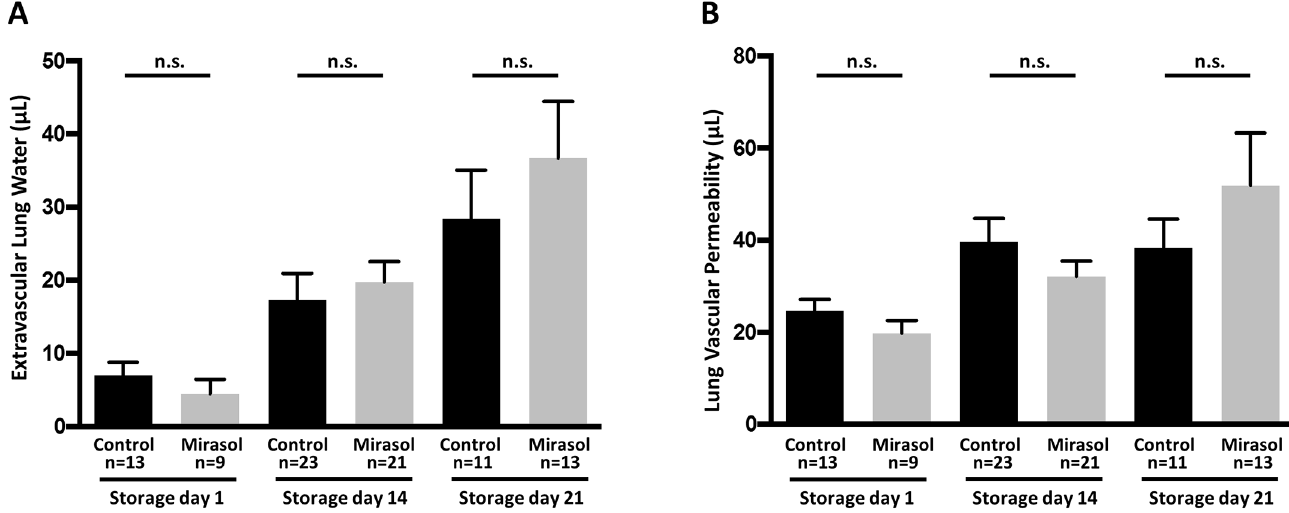
Fig 3. Lung injury measurements in control or Mirasol treated blood transfused into BALB/c SCID mice. LPS priming plus a 25% exchange transfusionusing Mirasol PRT-treated humanwholeblood stored for 1 (n = 9), 14 (n = 21), or 21 (n = 13) days versus untreatedcontrol human whole blood stored for 1 (n = 13), 14 (n = 23), or 21 (n = 11) days did not generatesignificantdifferences in extravascular lung water ( A ) or lung vascular permeability( B ) betweenthe two groups (all storage times non-significant control vs. Mirasol). However, extravascular lung water and lung vascular permeabilityincreasedwith blood storage time independentof Mirasol PRT treatment. For extravascular lung water, p < 0.01for trend in both Mirasol and control groups. For lung vascular permeability,p < 0.01for trend in Mirasol group and p = 0.11 for trend in control group (ANOVA). Mean ± SEM.